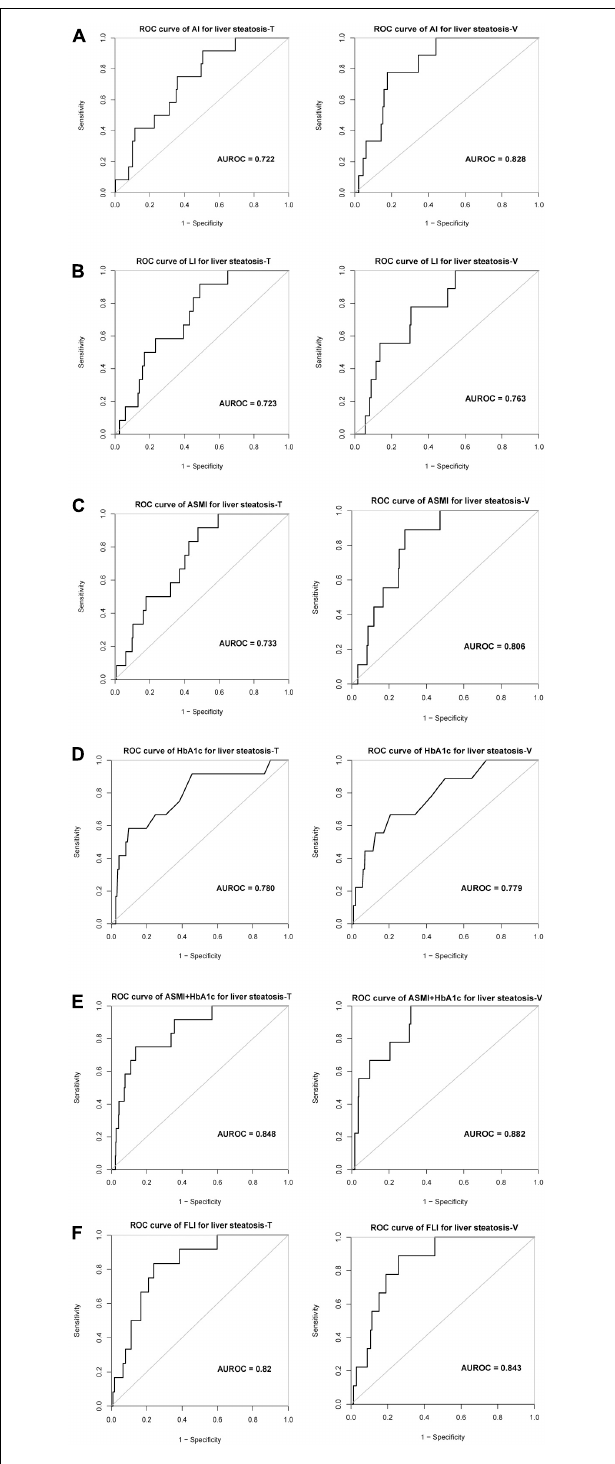
FIGURE 2 | The evaluation value of different indexes on severe liver steatosis of MAFLD patients. ROC curve and AUROC value of (A) AI, (B) LI, (C) ASMI, (D) HbA1c, (E) ASMI + HbA1c, and (F) FLI for liver steatosis in training and validation cohort. AI, Arms muscle index; LI, Legs muscle index; ASMI, Appendicular skeletal muscle index; FLI, Fatty liver index; AUROC, the area under the receiver operating